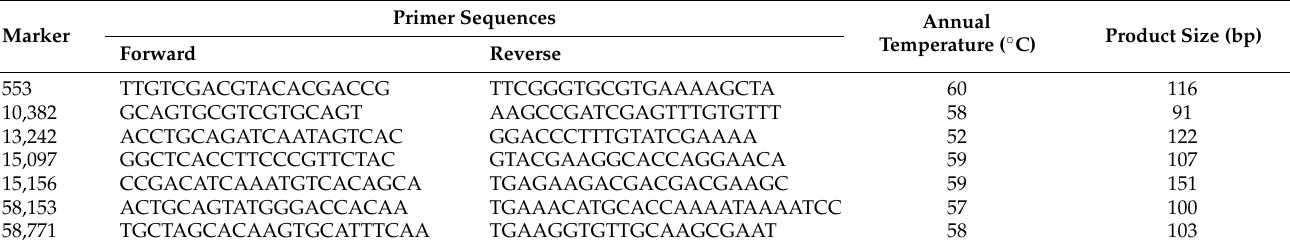
Table 5. Sequences of the designed primers for the identification of newly selected markers signifi- cantly related to the analyzed